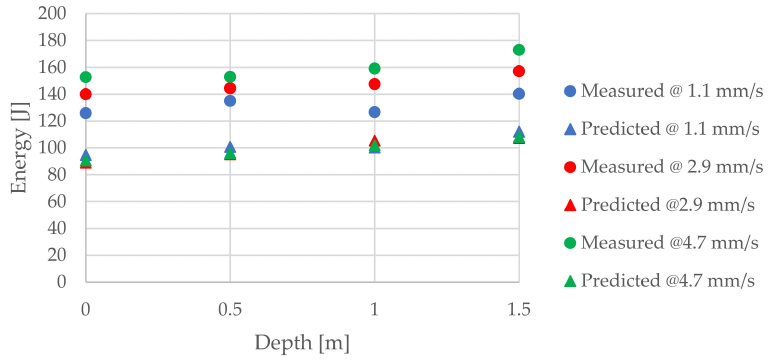
Figure 22. Predicted and measured values of energy at different depths (0 m, 0.5 m, 1 m and 1.5 m) and speeds (DC = 20%, DC = 50%, DC = 80%) when